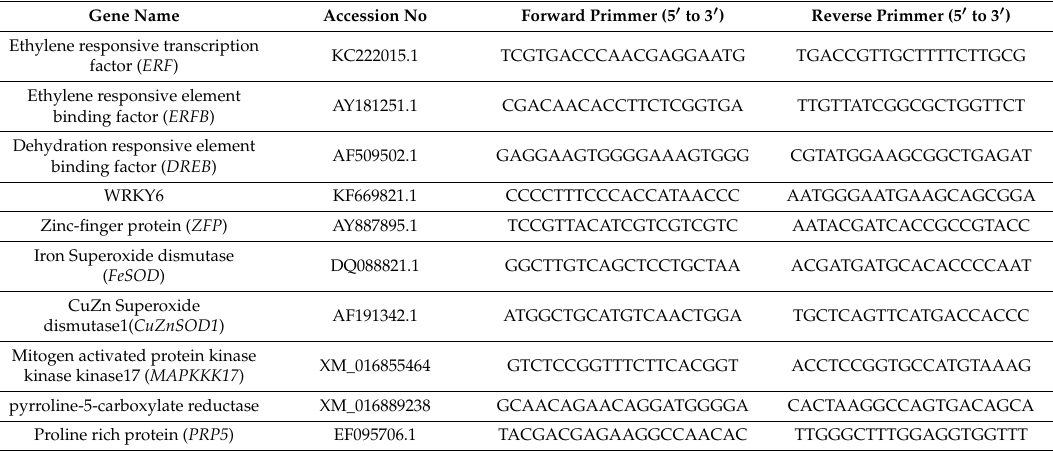
Table 3. List of primer sequences used for